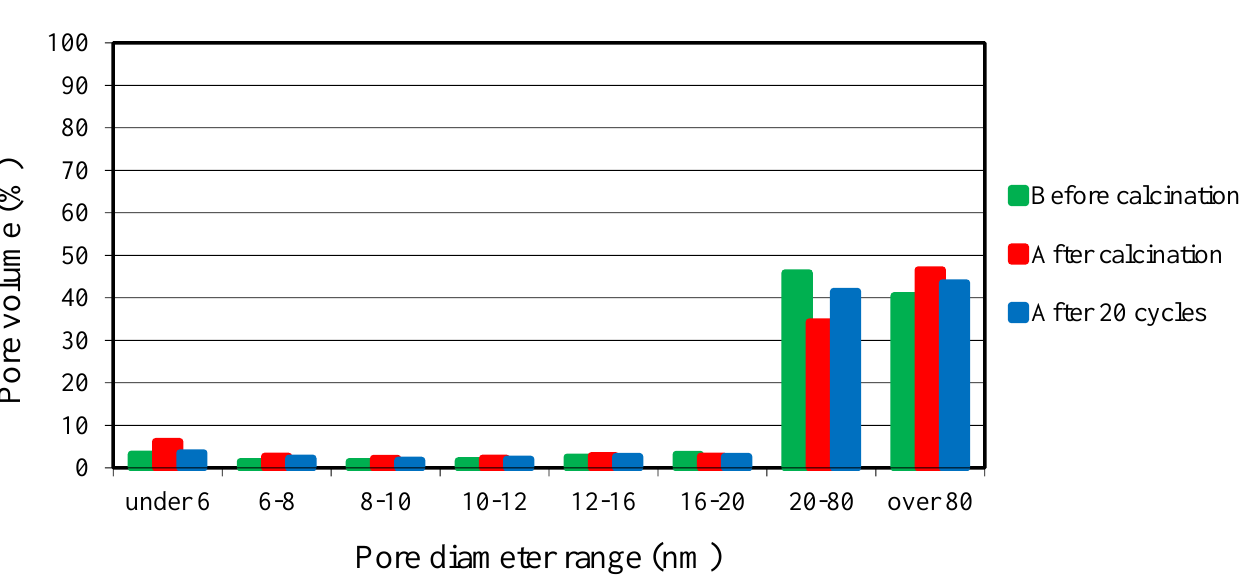
Figure 6. A comparison of Vitošov limestone pore size distribution before calcination, after calci- nation, and after 20 cycles.